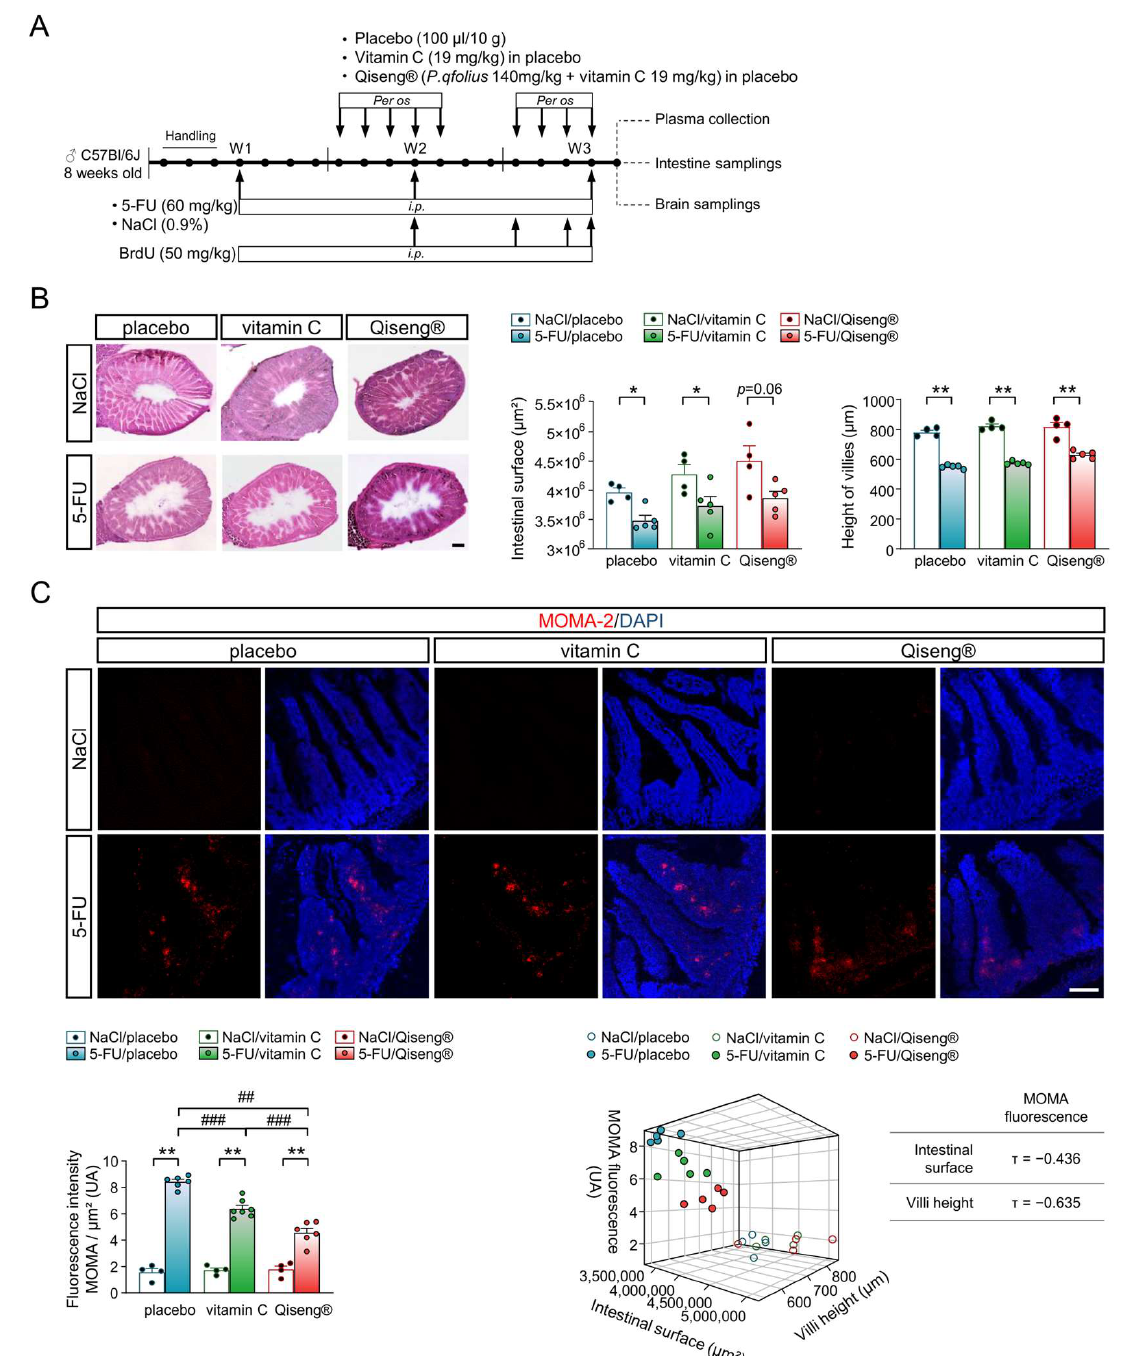
Figure 6. Impact of 5-FU treatment, vitamin C and Qiseng ® on intestinal integrity and macrophages infiltration. ( A ) Schematic timeline for treatments and intestine sampling from the different groups of mice for studying small intestinal tissue integrity. ( B ) Representative microphotography of eosin/hematoxylin staining from intestinal transversal sections prepared from the NaCl/ and 5-FU/placebo, vitamin C and Qiseng ® -treated mice ( Left ) and intestinal surface and villi height quantifications. Scale bar: 200 µ m. Data are represented as bar plots of mean ± SEM with symbols of individual data points ( n = 4–5, Kruskal–Wallis-Dunn post hoc; * p < 0.05, ** p < 0.01, ns: not significant). ( C ) Representative microphotography of the monocyte/macrophage specific marker MOMA-2 (red) in villi of small intestine in NaCl/ and 5-FU/placebo, vitamin C and Qiseng ® -treated mice. Fluorescence quantification of the effects of 5-FU, vitamin C and Qiseng ® on intestinal macrophage infiltration. Bottom left, data are represented as bar plots of mean ± SEM with symbols of individual data points ( n = 4–5, Kruskal–Wallis-Dunn post hoc; ** or ## p < 0.01, ### p < 0.001, ns: not significant). Star indicates statistical difference within the same group, and hash indicates statistical difference between 5-FU groups. Scale bar: 100 µm. Bottom right, scatterplot in 3D illustrating the relationships between the MOMA-2 staining, villi height and the intestinal surface from the different treated